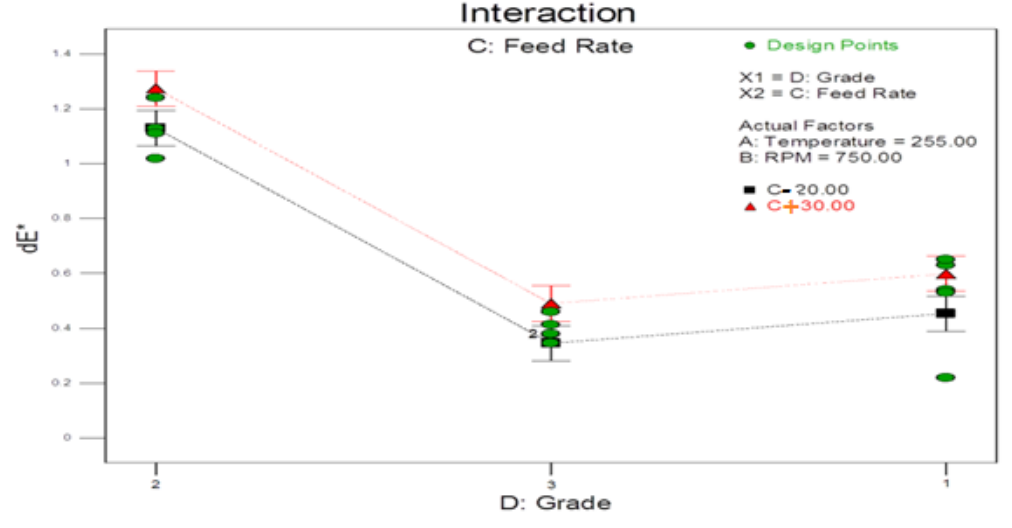
Figure 7. Effect of feed rate on dE* for Grade 1, Grade 2 and Grade 3.